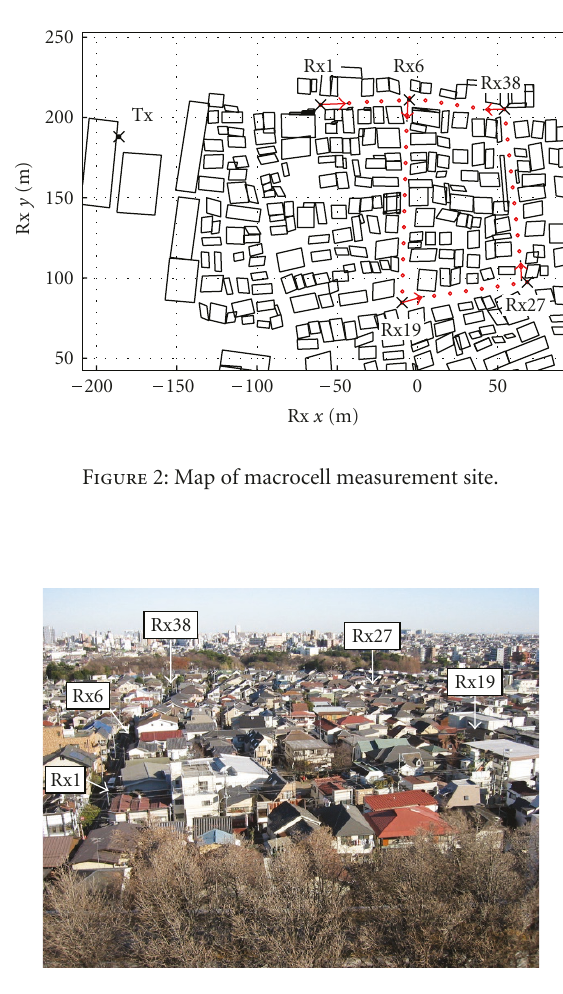
Figure 3: Picture taken from Tx in the direction of Rx6